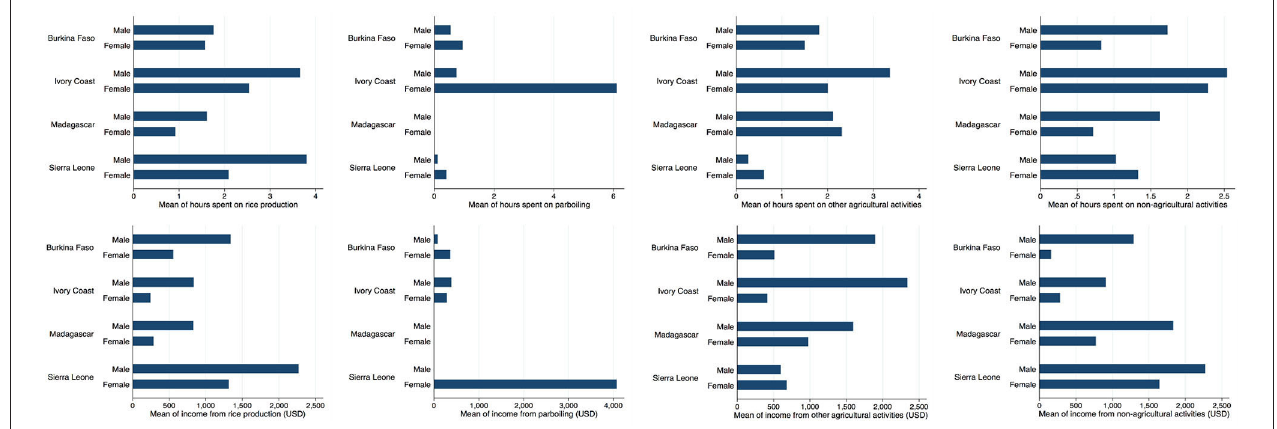
FIGURE 1 | Cross-country comparison of male and female farmers’ labor inputs and income from various productive activities in Burkina Faso, Côte d’Ivoire, Madagascar, and Sierra